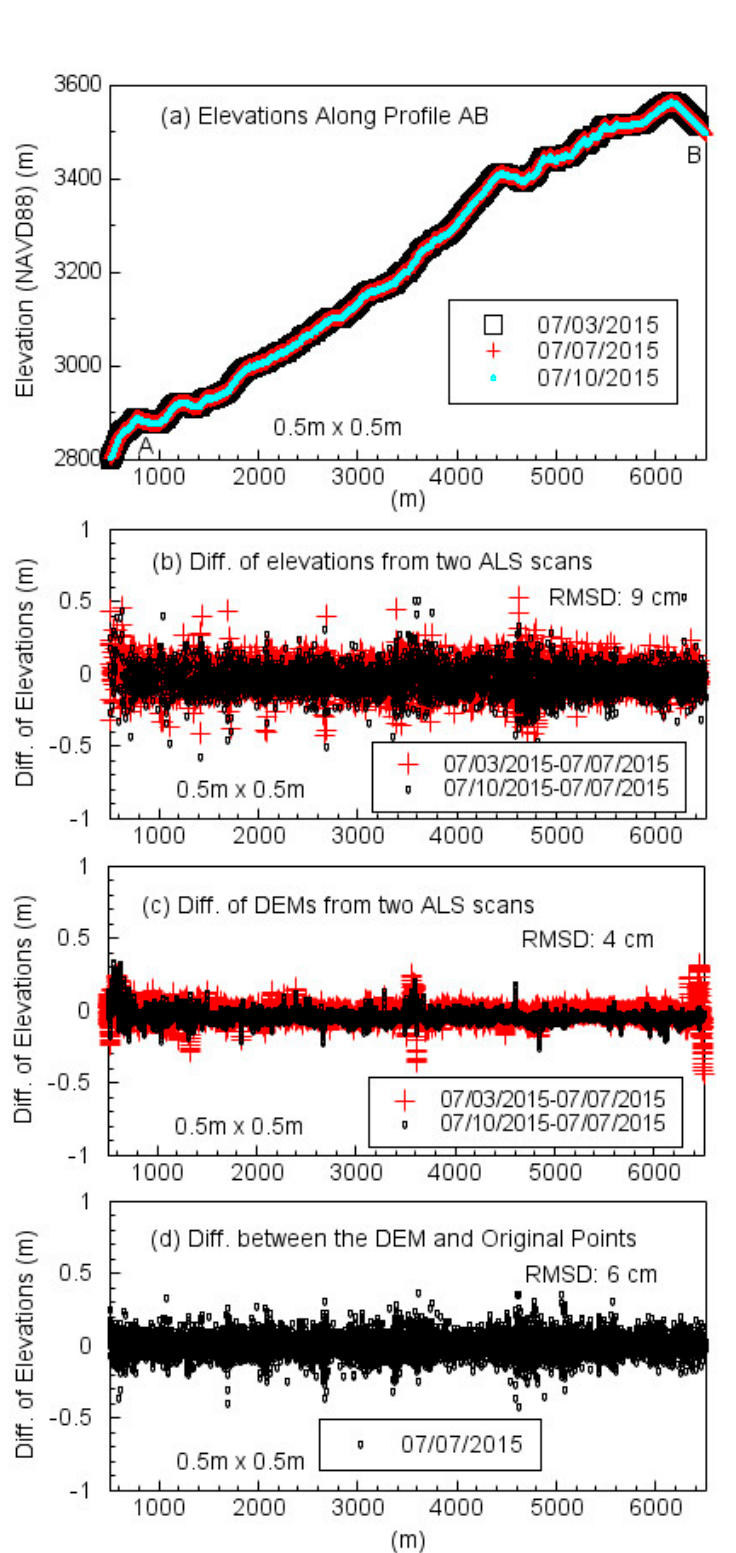
Figure 8. Plots illustrating the vertical precision of bare-earth ALS points. The point clouds have been down-sampled into unified grid cells (0.5-m by 0.5-m). ( a ) Elevation measurements from three ALS surveys along profile AB (Figure 3a). ( b ) Elevation differences of discrete points between two ALS surveys on 3 July and 7 July, and 10 July and 7 July 2015. ( c ) Elevation differences of two DEMs (DDEM) along with profile AB. ( d ) Elevation differences between ALS points and gridded DEM points.